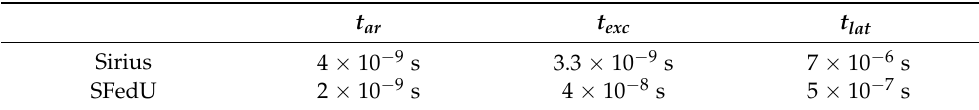
Table 1. Characteristics of multiprocessor systems SFedU and Sirius University of Science and Technology for which experiments were performed. t ar t exc t lat Sirius 4 × 10 − 9 s 3.3 × 10 − 9 s SFedU 2 × 10 − 9 s 5 × 10 − 7 s Experiments were carried out to solve the model problem of convection-diffusion on